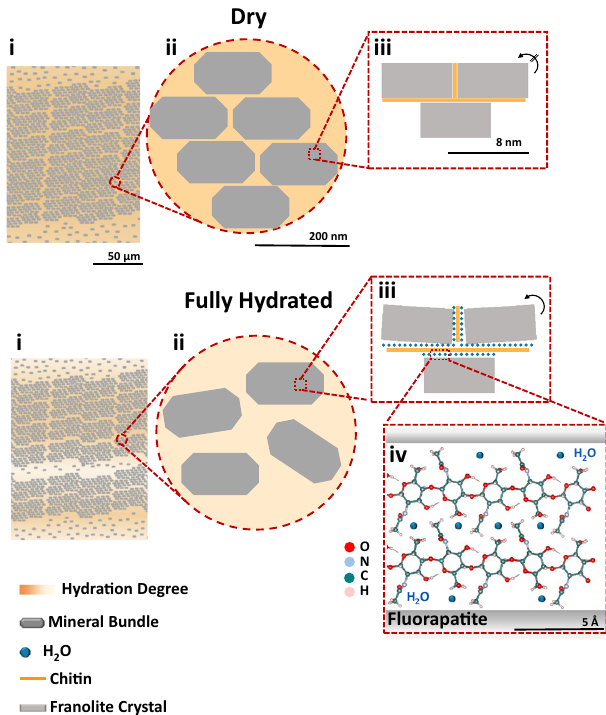
Fig. 7 Hydration scheme of a D. tenuis brachiopod shell. Schematic of the proposed hydration mechanism across length scales from the micron (i), sub-micron (ii), nano (iii), and molecular level (iv) 33, 68, 69 . In (iii) and (iv), we propose that the intercalation of water between the mineral and chitin enables the mineral units to move more freely when a load is applied.